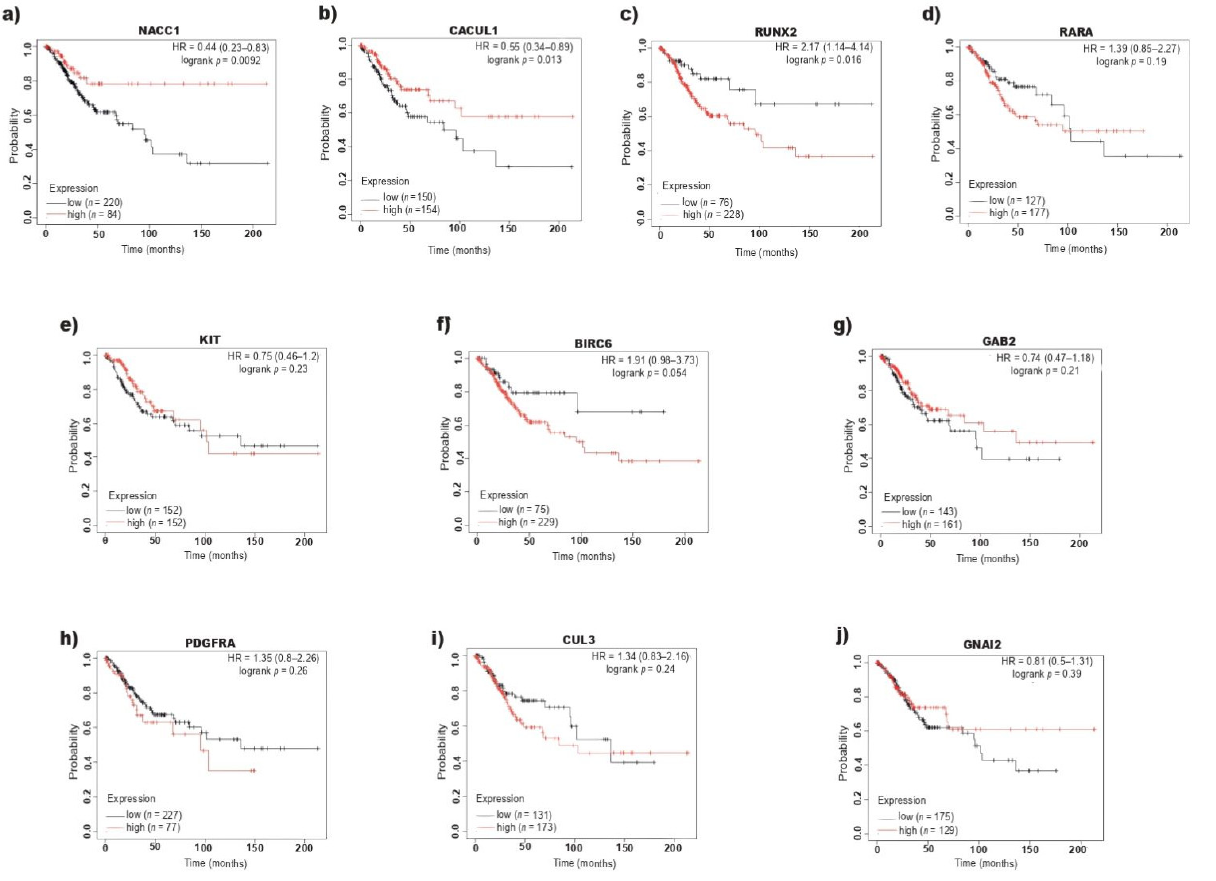
Figure 3. Effects of expression of miR-218-5p target genes on the survival of patients with CC. ( a – j ) Analysis of prognostic value of miR-218-5p target genes involved in the positive regulation of cell proliferation in cervical tissue of CC patients. ( a ) NACC1, ( b ) CACUL1, ( c ) RUNX2, ( d ) RARA, ( e ) KIT, ( f ) BIRC6, ( g ) GAB2, ( h ) PDGFRA, ( i ) CUL3, ( j ) GNAI2. The Kaplan–Meier survival curves show the prognostic importance for NACC1, CACUL1 and RUNX2. ( p < 0.05). The red line represents the patients with high expression and the black line represents the patients with low expression of miR-218-5p target genes.